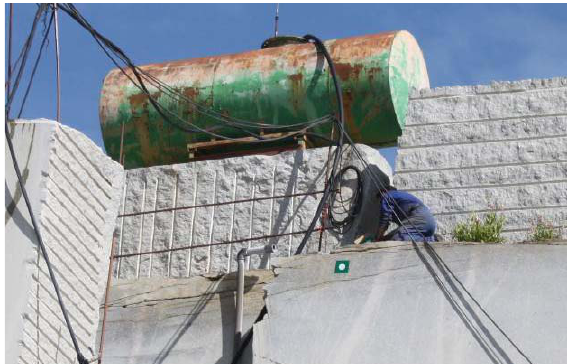
Figure 3. Artificial target located in the vertical wall of the